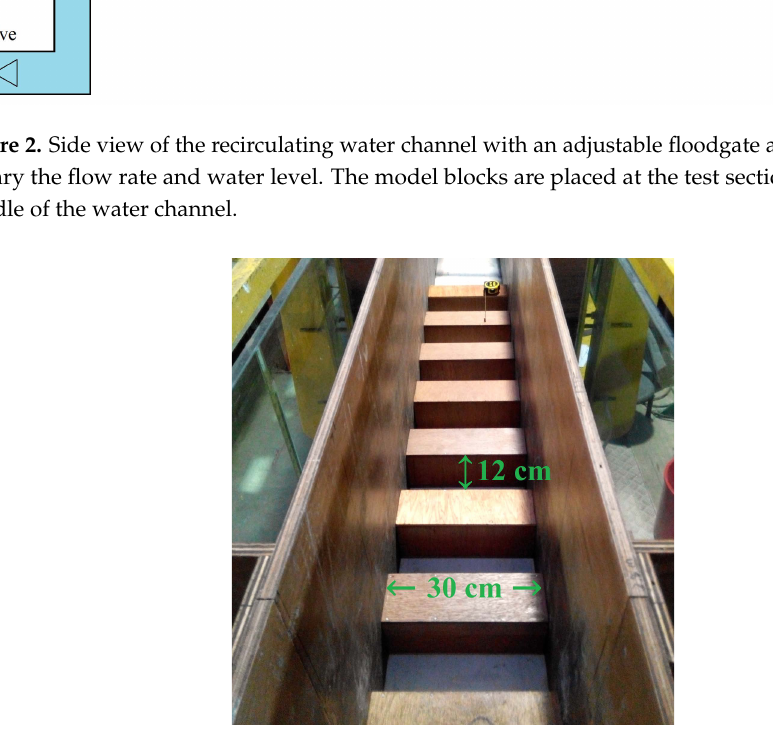
Figure 3. Arrangement of model blocks in the test section to form seven canyons of aspect ratio 1 with height, H = 12